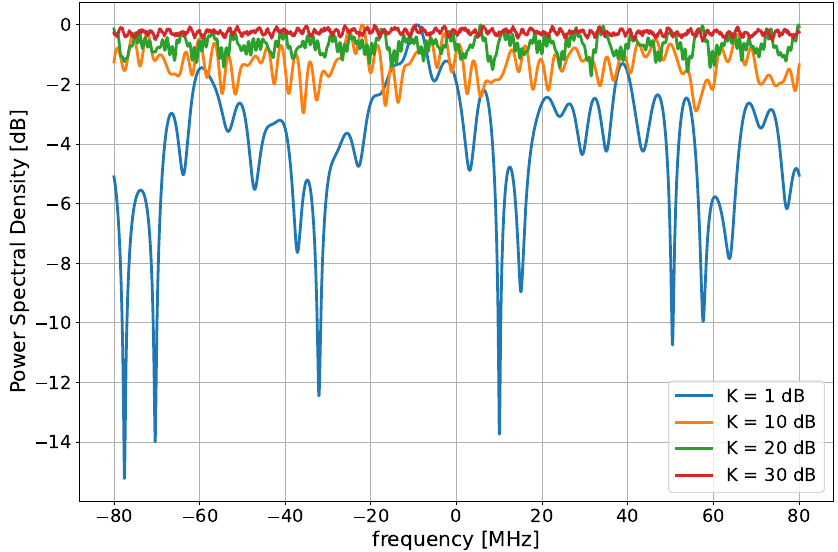
Figure 8. Power spectral densities for a different value of the Rice factor K.